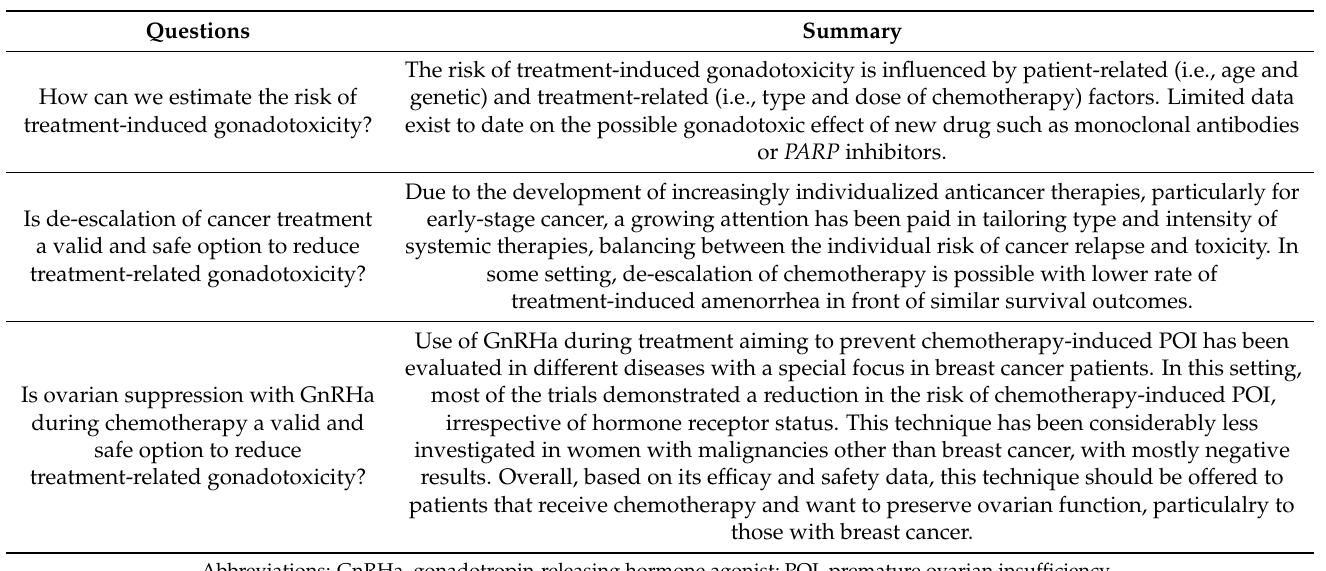
Table 5. Overview of the main concepts concerning the use of GnRHa in reducing the risk of POI in patients undergoing gonadotoxic